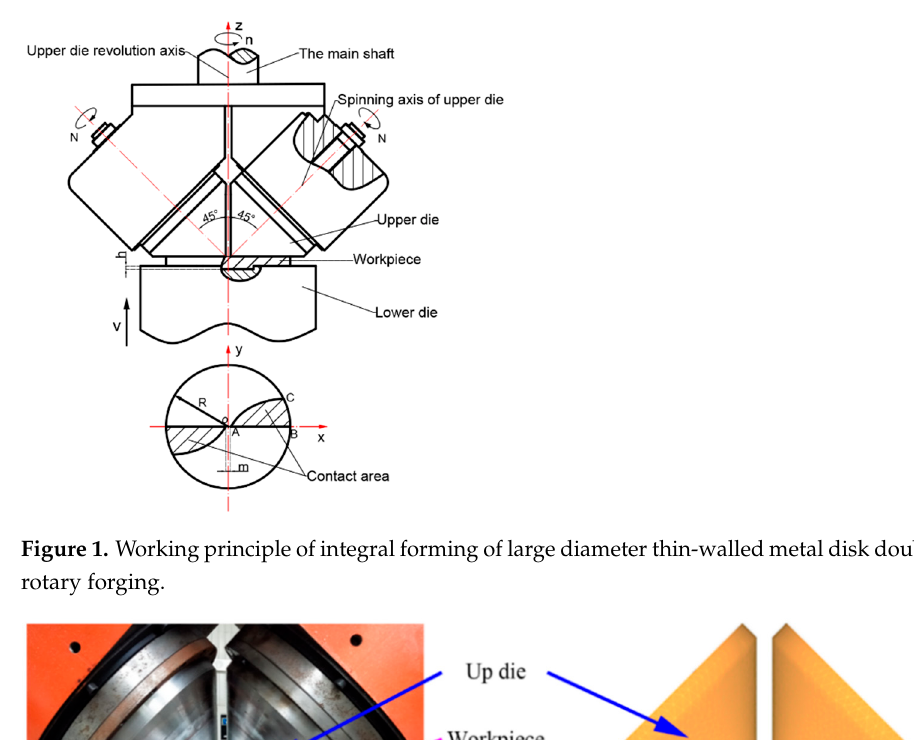
Figure 1. Working principle of integral forming of large diameter thin-walled metal disk double- roller rotary forging.